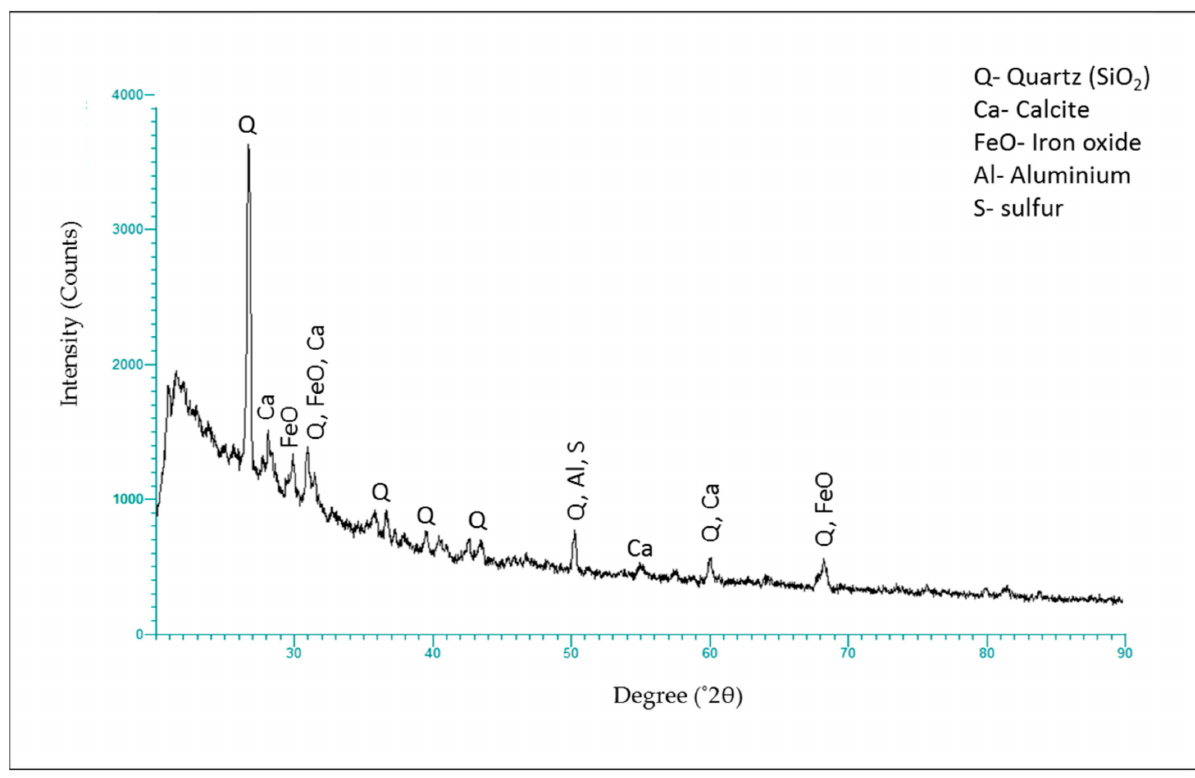
Figure 7. X-ray diffraction (XRD) analysis of BA.